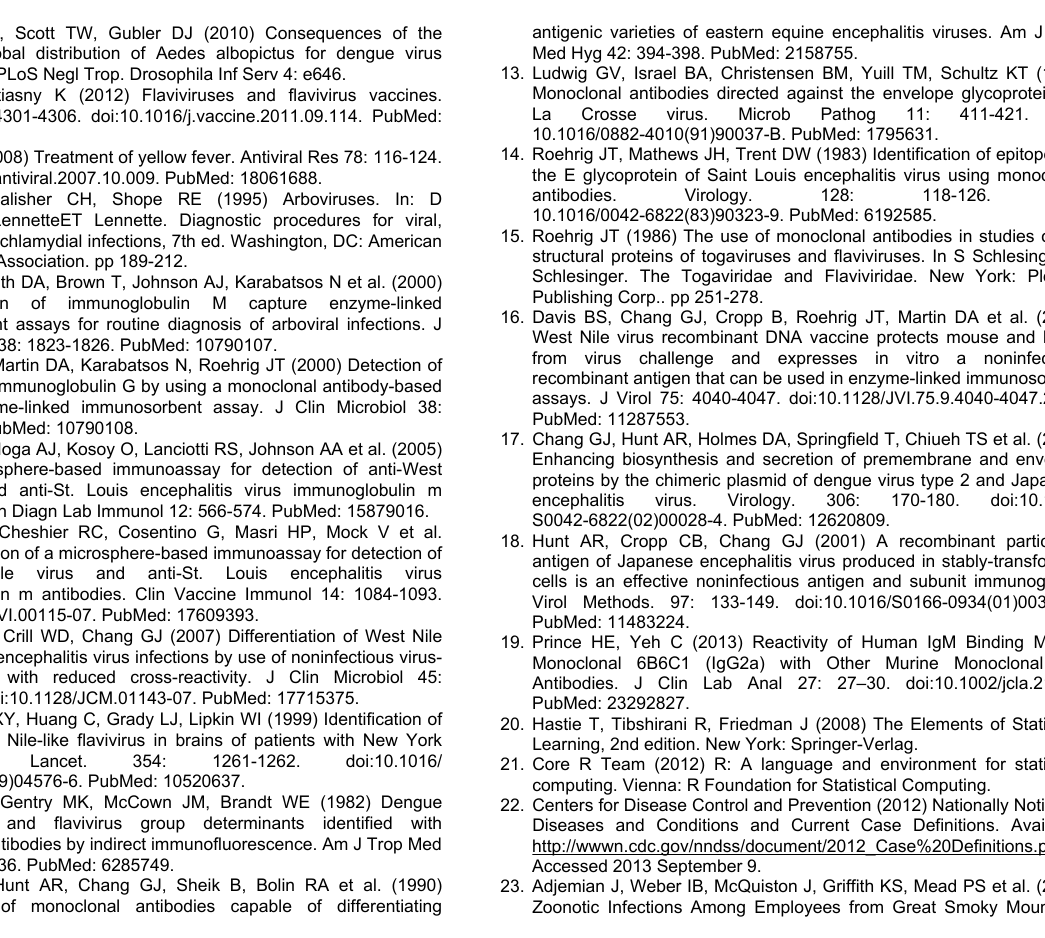
Table S2. Internal control data based on summer 2011 samples. (XLSX) Figure S1. True classification versus test values of initial data set: Figure S1a) V/N of IgM results; Figure S1b) P/N of IgM results; Figure S1c) V/N of IgG results; Figure S1d) P/N of IgG results.